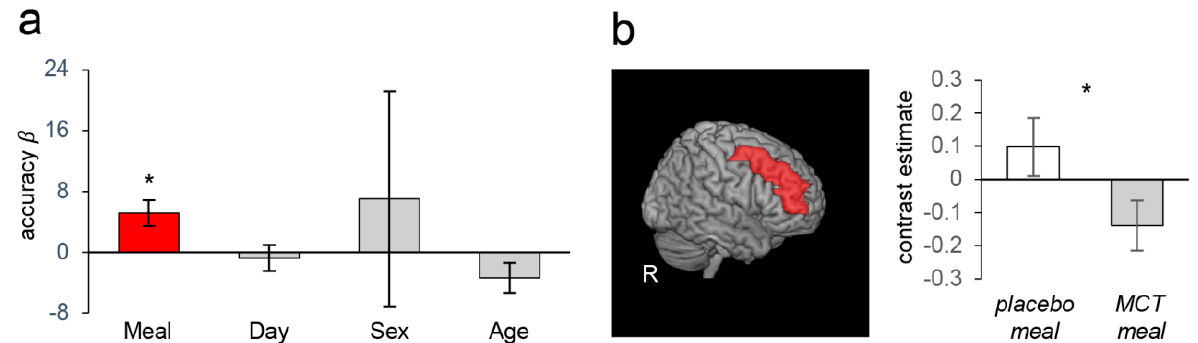
Figure 5. Behavioural and fMRI results of analyses in the low group. ( a ) The effects ( β weights) on the accuracy in the no-go trials based on meal (MCT/placebo), day (1st/2nd visit), sex, and age. Consuming the MCT meal significantly improved the accuracy. Error bars depict SEMs; * p < 0.05. ( b ). fMRI BOLD analysis. Left: right DLPFC region of interest (ROI) used in the BOLD analysis (red area). Right: Consuming the MCT meal significantly decreased the BOLD response to the inhibitory control load during the Go-Nogo task. * p < 0.05.